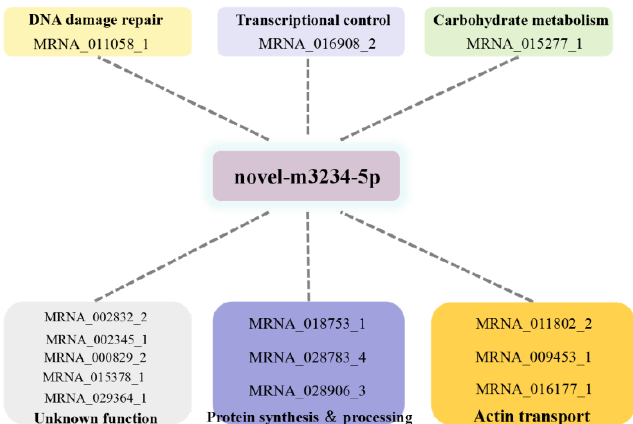
Figure 10. Cluster analysis of the transcript expression pattern of target RNAs of novel-m3234-5p in S. japonica .